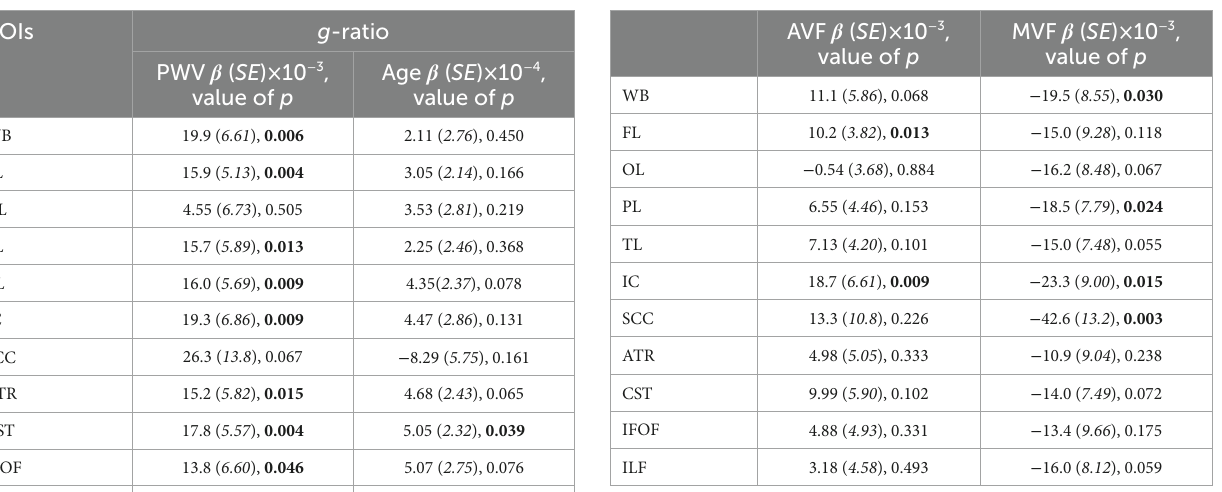
TABLE 3 Regression coefficient ( β ) (standard error ( SE ) in italics), and significance (value of p ) of AVF or MVF vs. PWV across 11 WM ROIs.